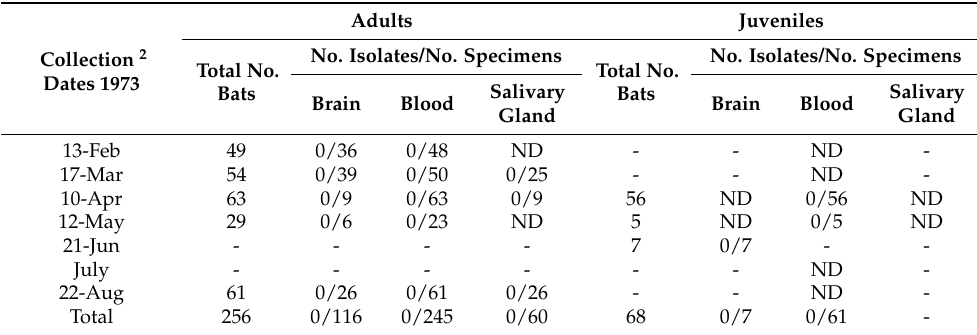
Table 7. A summary of virus isolation attempts from tissues of adult and juvenile wrinkle-lipped free-tailed bats collected from Kaeng Khoi cave 1